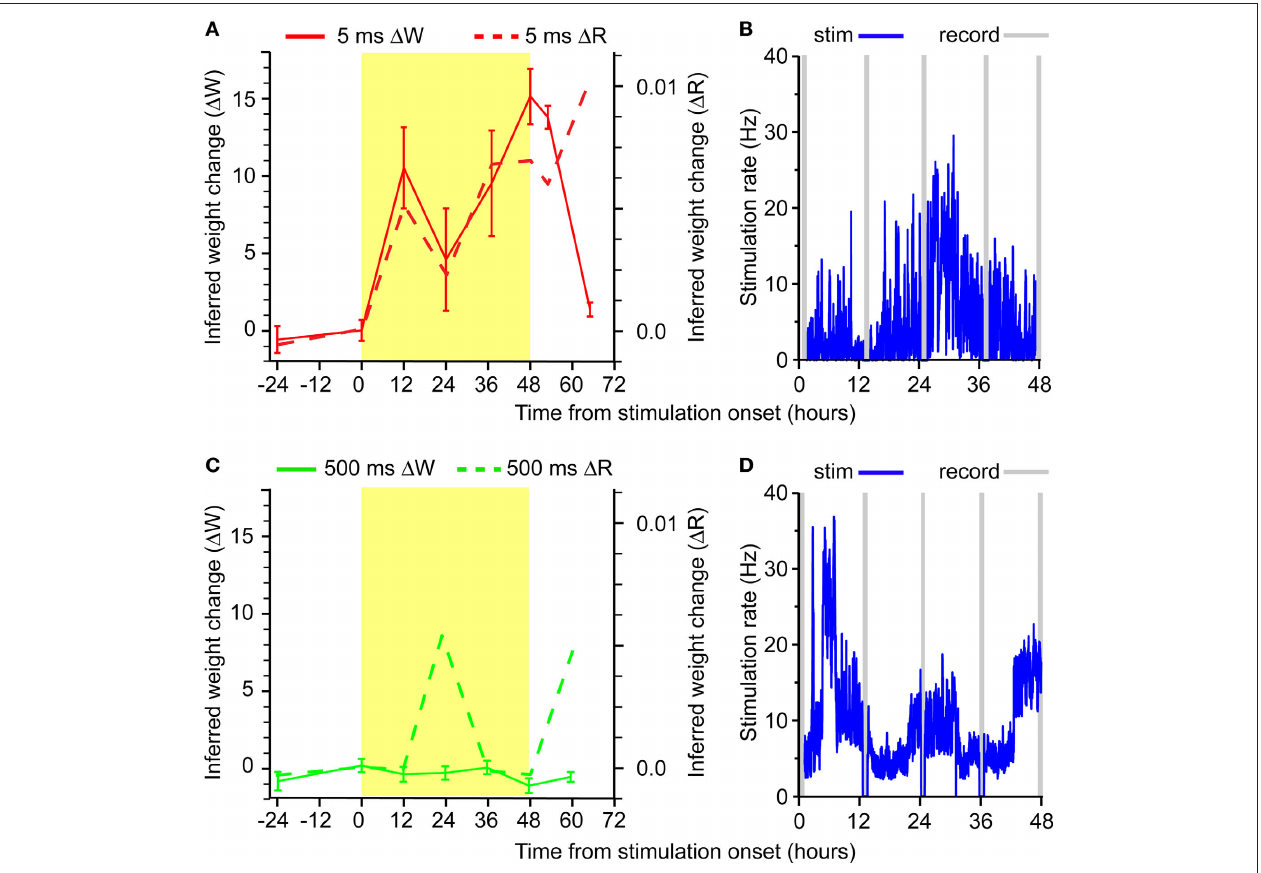
Figure 3 | Timecourse of trigger-to-target ∆ W and ∆ R . Stimulation took place during the 48-h window shown in yellow. (A) Latency between trigger spike and target stimulation was 5 ms. (B) Stimulation rate (binned at 1 min) for the experiment shown in (A) . (C) Latency between trigger spike and target stimulation was 500 ms. (D) Stimulation rate for the experiment shown in (C)